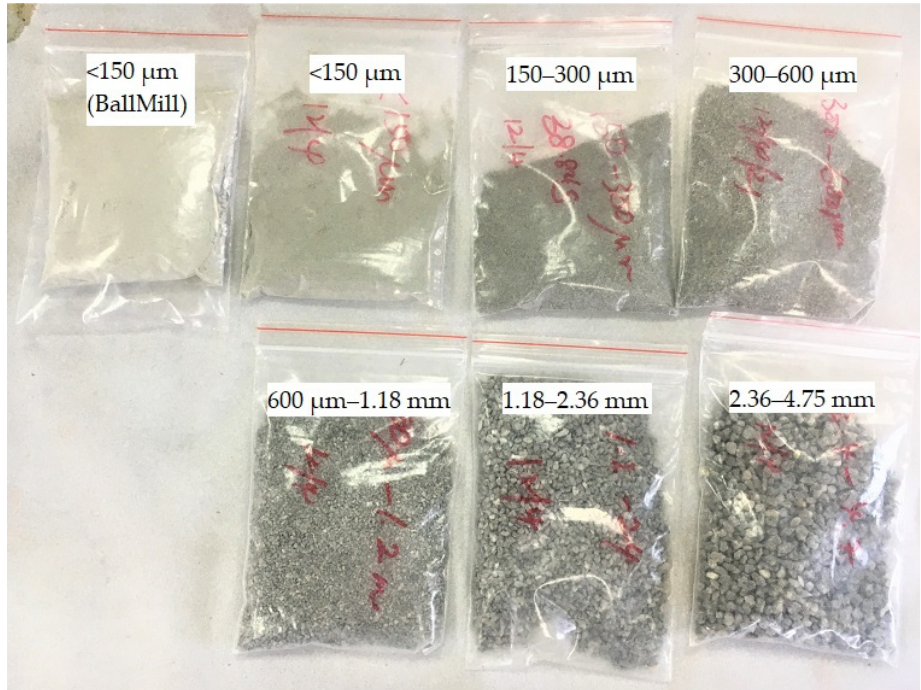
Figure 3. Samples stored in individual, sealed plastic